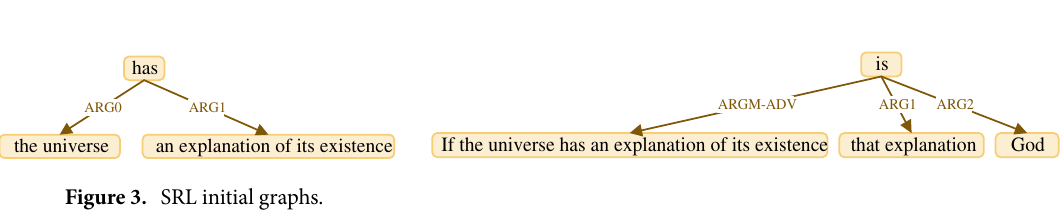
Figure 3. SRL initial